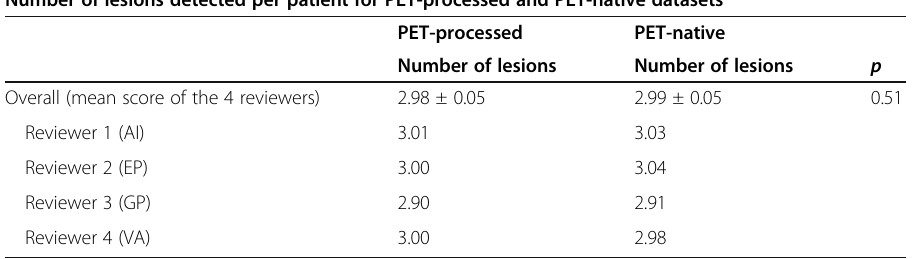
and by each individual reviewer Number of lesions detected per patient for PET-processed and PET-native